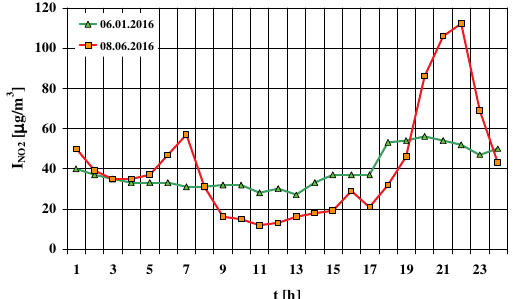
Fig. 10. The immission of nitrogen dioxide values obtained from Kraków– Kurdwanów station on 6 January 2016 and 8 June 2016 It is similar to nitrogen oxides immission – Figs 11–15.